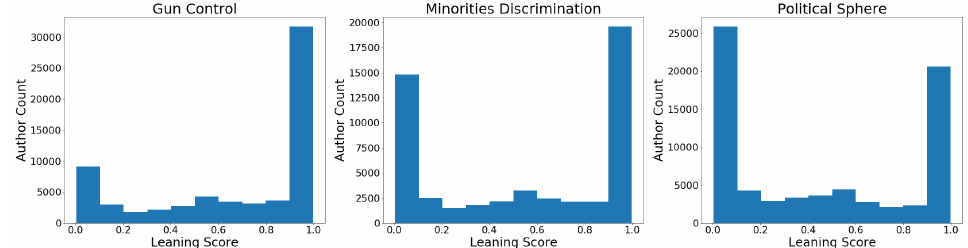
Figure 2. Authors’ leaning score distribution for each sociopolitical